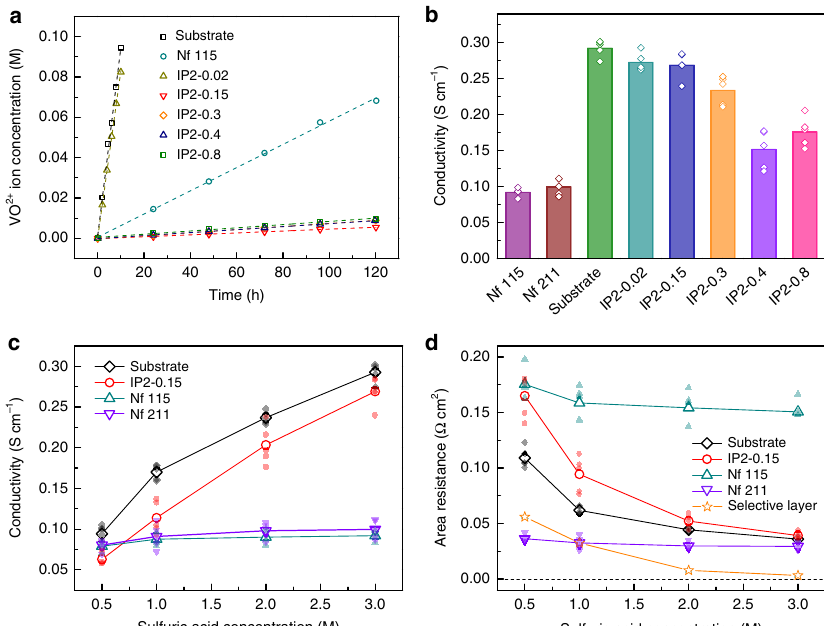
Fig. 2 The selectivity and conductivity of thin- fi lm composite membranes. a Vanadium concentrations in the magnesium sulfate solution at the permeate side versus time. b Cross-membrane conductivity of different membranes. c , d The change of cross-membrane conductivity ( c ) and area resistance ( d ) with the sulfuric acid concentration. The area resistance of the selective layer equals to the difference between the area resistance of the substrate and of the IP2-0.15. Data behind each average are represented by smaller symbols. Nf represents Na fi on. Source data of b – d are provided as a Source Data fi